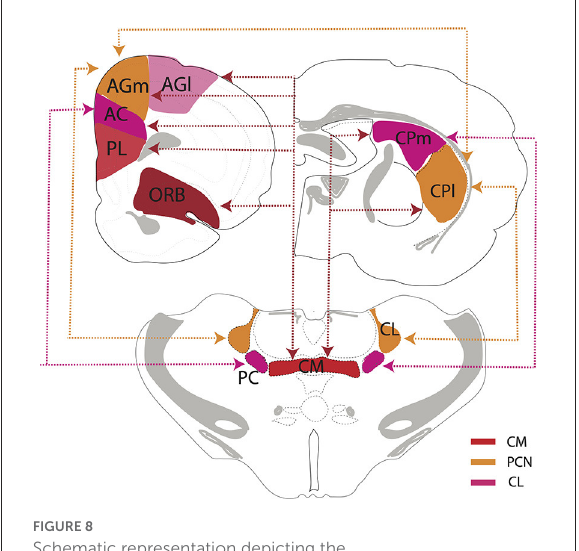
FIGURE8 Schematic representation depicting the interconnections/circuitry between the rostral intralaminar thalamus, the dorsal striatum, the medial prefrontal, orbital and frontal motor cortices. The paracentral (PC) and central lateral (CL) nuclei are reciprocally linked to separate but overlapping regions of the frontal cortex and dorsal striatum. CL is reciprocally linked to the secondary motor cortex (AGm) and the lateral aspect of dorsal striatum (CPl) and AGm and CPl in turn reciprocally connected. By comparison, PC is reciprocally linked to the anterior cingulate cortex (AC) and medial aspect of the dorsal striatum (CPm), and AC and CPm are, in turn, reciprocally connected. By contrast with CL and PC, the central medial nucleus (CM) is much more widely interconnected with striatal-cortical circuitry as CM is reciprocally connected with entire frontal/prefrontal cortex (PL, AC, AGm, AGl), the medial and lateral dorsal striatum and add additionally the orbital cortex (ORB). Accordingly, CM may represent a conduit linking striatal, limbic and motor systems of the forebrain. PL, prelimbic cortex, AGl, primary motor cortex.